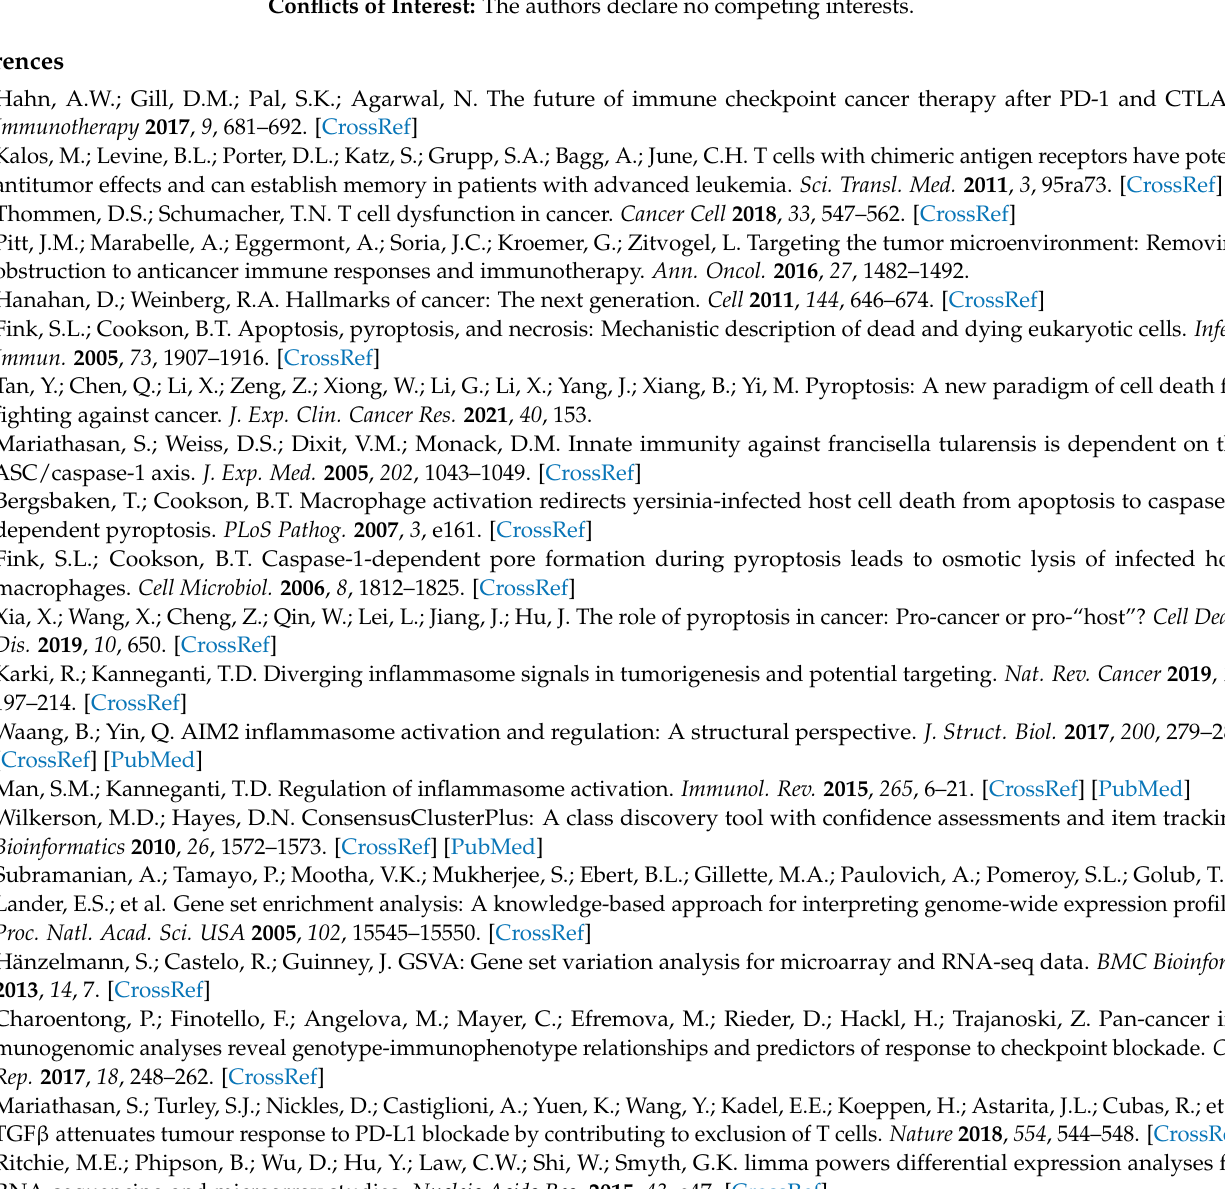
score. Table S5: Differential expression analysis between pyroptosis cluster A, pyroptosis cluster B, and pyroptosis cluster C. Table S6: Univariant analysis that identified 589 prognostic pyroptosis pattern-related signature genes